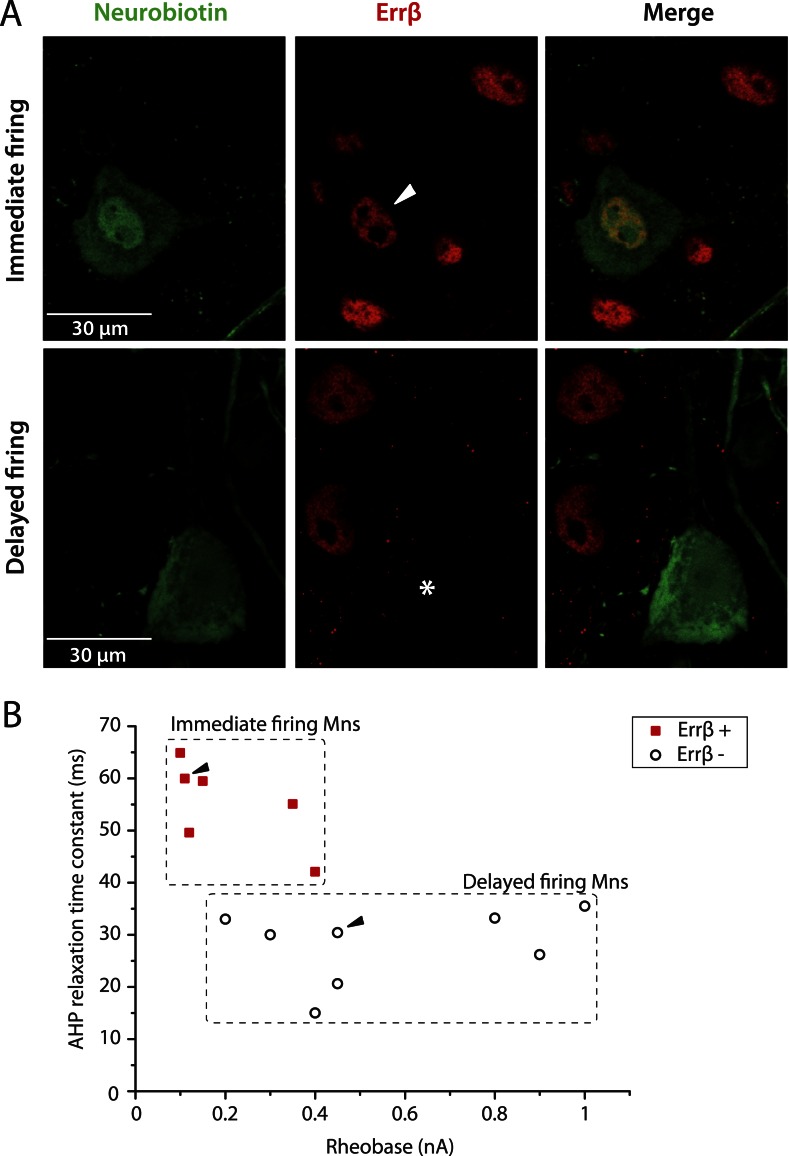
Immediate firing motoneurons, but not delayed firing motoneurons, express ERRβ.(A) Examples of Errβ. staining (red) in neurobiotin (green) filled motoneurons. The arrowhead in the first row points to the nucleus (Errβ−positive) of the recorded motoneuron. The asterisk in the second row indicates that the nucleus of the recorded motoneuron was Errβ−negative. (B) Plot of the AHP relaxation time constants against the rheobases for labelled motoneurons. All immediate firing motoneurons were Errβ−positive whereas all delayed firing motoneurons were Errβ−negative. Arrowheads point to the motoneurons illustrated in A.